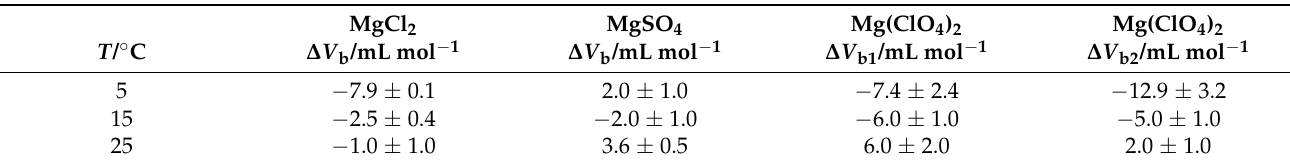
Table 3. Binding volumes ( ∆ V b ) for the BSA:ANS complex formation at the indicated temperatures and in the presence of 250 mM MgCl 2 , MgSO 4 , and Mg(ClO 4 ) 2 . The ∆ V b values are reported in mL mol − 1 of protein.